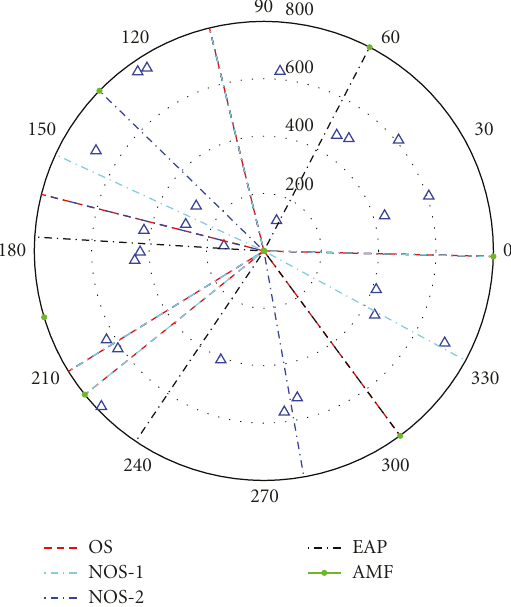
Figure 8: Sector boundaries for the downlink of a CDMA system with uniform user distribution. Number of users, M = 25; process- ing gain, N = 16; number of sectors, K =